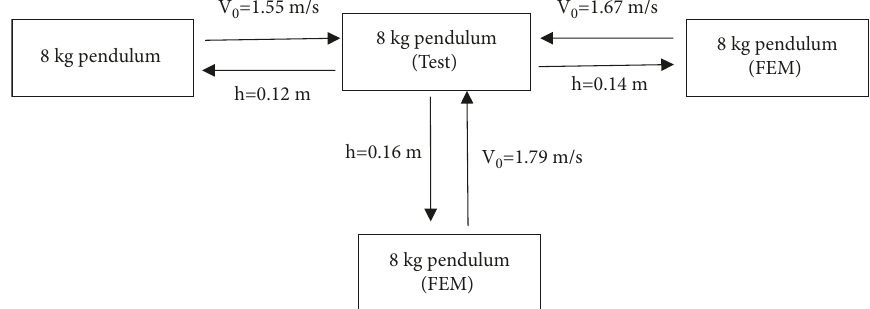
Figure 3: Test verification impact load